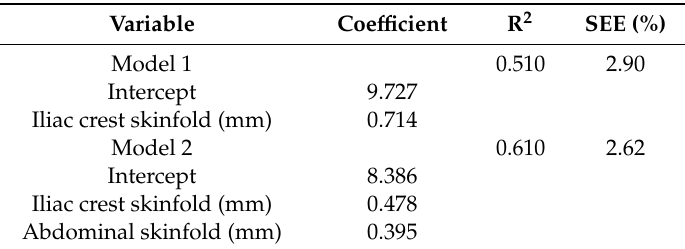
Table 4. Developed models for FM% prediction.